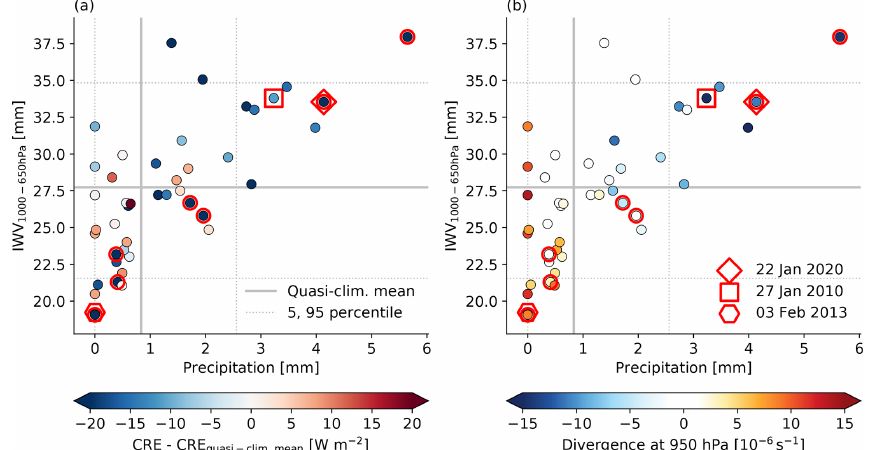
Figure 9. The relation between daily mean IWV 1000–650hPa , daily precipitation totals, and (a) the anomaly in daily mean CRE relative to the quasi-climatological mean or (b) daily mean low-level divergence at the BCO is shown for the 44 EDI days. The quasi-climatological means are shown as continuous gray lines, and the 5th and 95th percentiles are shown as dashed gray lines. The red geometrical shapes indicate three specific dates, while the points with a thick red edge belong to the 33d with the strongest cloud radiative cooling. Note that the daily mean values are based on 3-hourly data; thus, the values are not directly comparable to Fig. 6. Data: